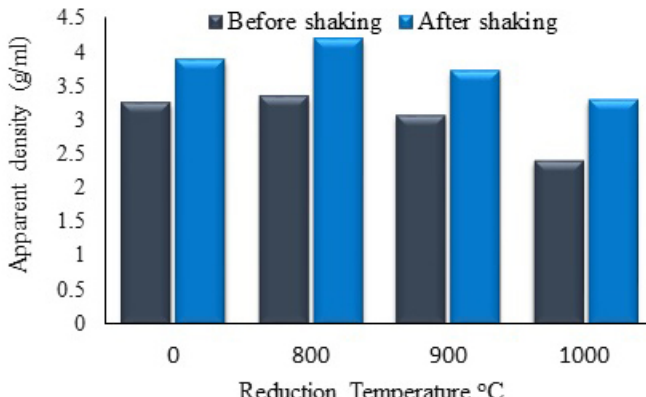
Figure 13. Measured density of iron powder produced at different reduction temperatures before and after shaking.